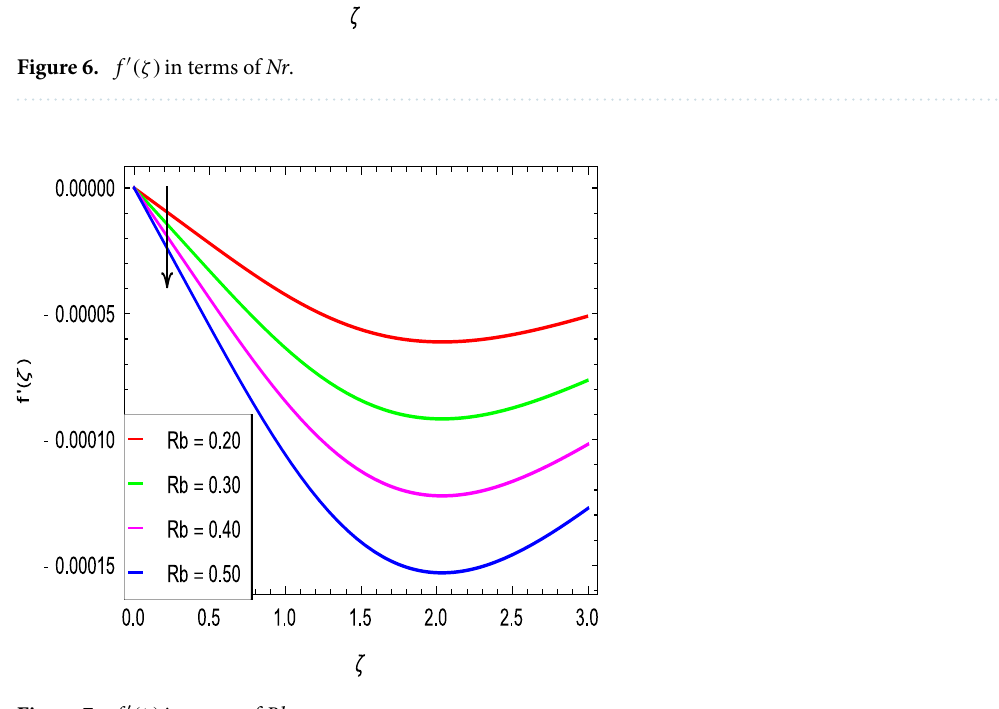
Figure 7. f ′ (ζ) in terms of Rb